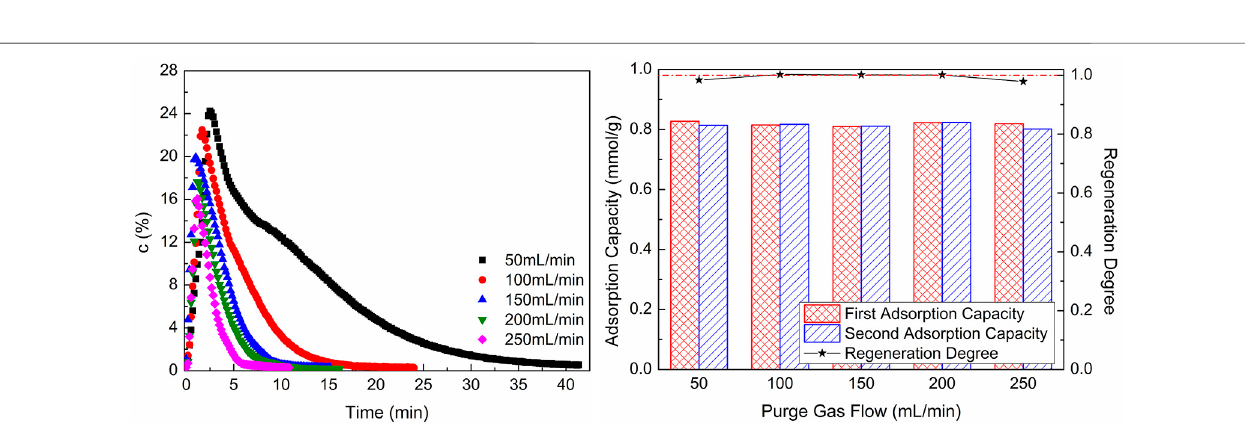
Frontiers in Energy Research |